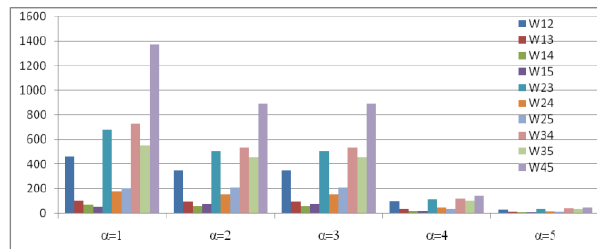
Figure 10 Number of users who are active within two windows out of five depending on α value